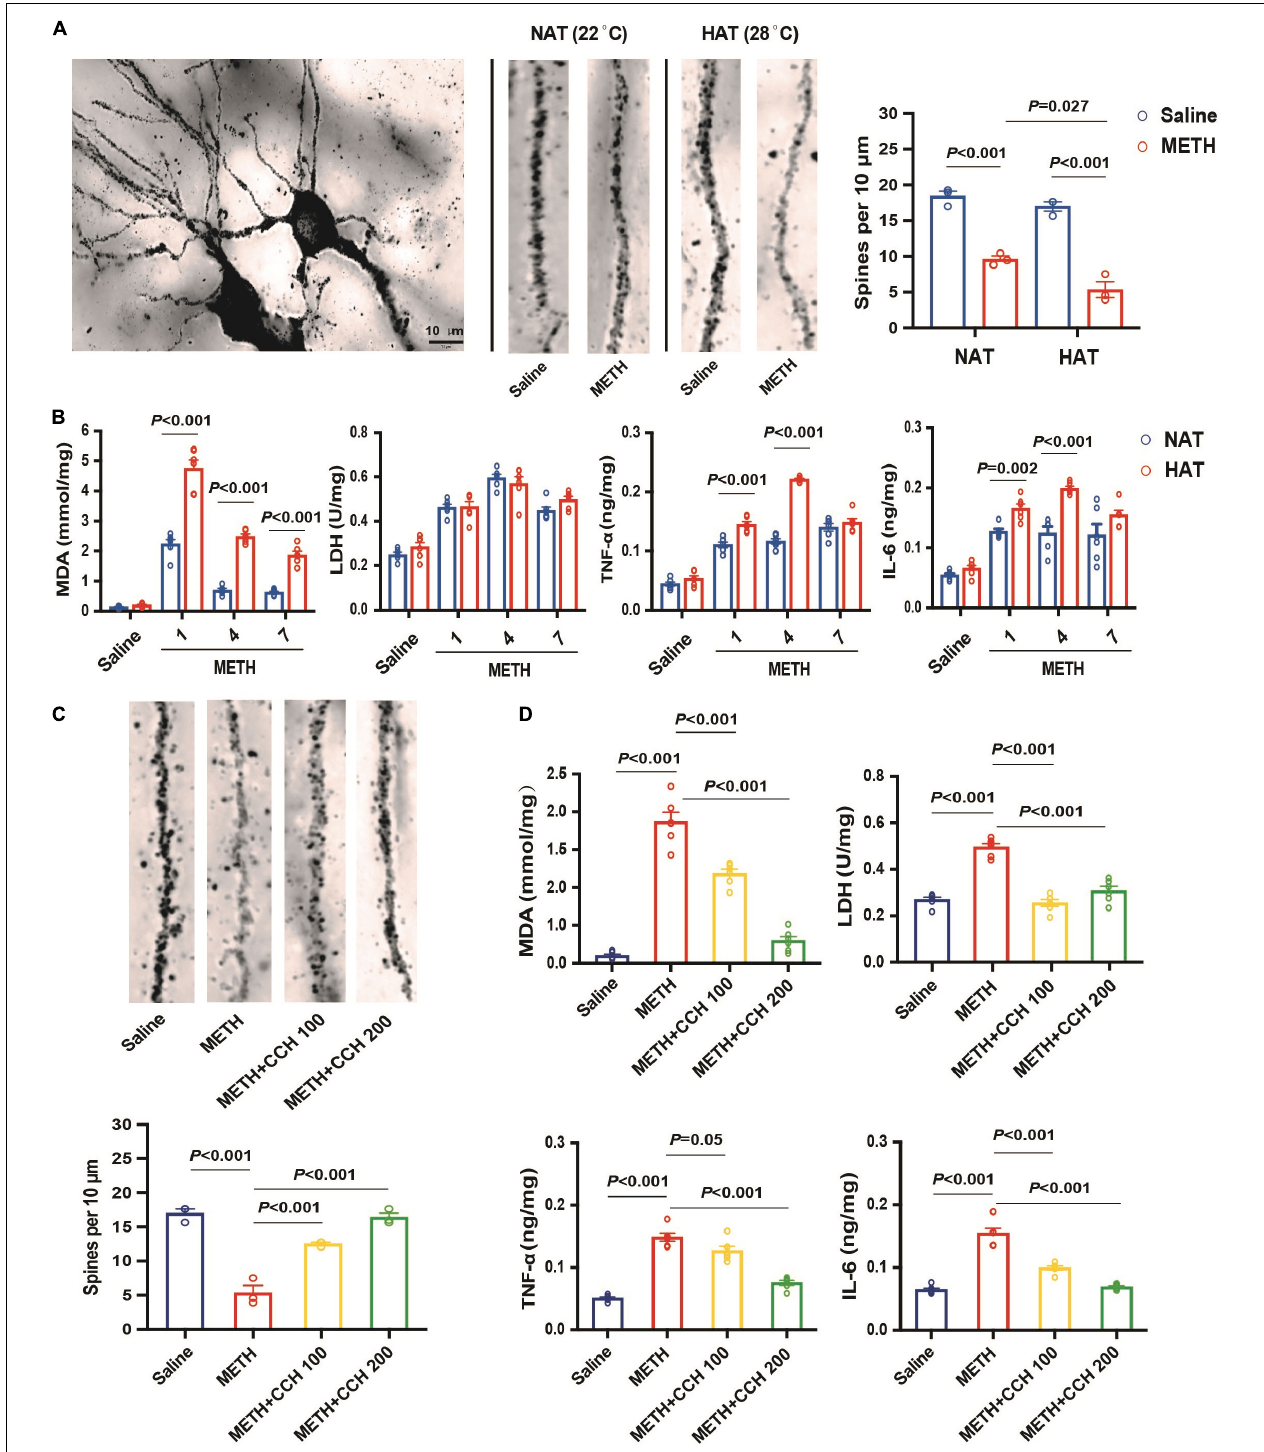
FIGURE 4 | Coral calcium hydride administration inhibited METH-induced hippocampal synaptic plasticity damage, oxidative stress, and neuroinflammation. (A) HAT aggravated METH-induced hippocampal synaptic plasticity damage. The number of spines in hippocampal neuron was significantly decreased after METH treatment, especially when it given under HAT. Bar = 10 µ m. (B) METH elicited time-dependent oxidative stress and neuroinflammation in hippocampus. HAT compounded METH-induced increase of MDA, TNF- α , and IL-6 levels, but did not change the activity of LDH. (C) CCH administration attenuated METH-induced hippocampal synaptic plasticity damage. (D) CCH administration inhibited METH-induced secretion of oxidative stress products and inflammatory cytokines in hippocampus. Data are expressed as the mean ± SEM ( n = 3 per group in Golgi staining; n = 6 per group in measurement of MDA, LDH, TNF- α , and IL-6 levels).